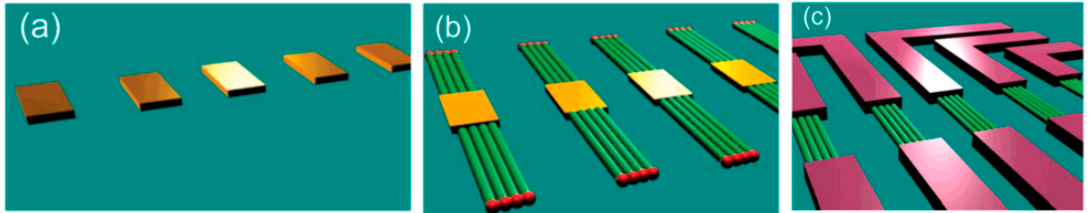
Figure 34. Schematic of the photolithography process for a scalable fabrication of nanowire devices. ( a ) Gold pads and fiducial marks are deposited on the surface. ( b ) NWs are grown selectively from the two sides of the gold pads. ( c ) Metal electrodes and bonding pads are placed exactly on NWs by the alignment of fiducial marks. Reproduced with permission from Nikoobakht [319]. Copyright 2007: American Chemical Society.